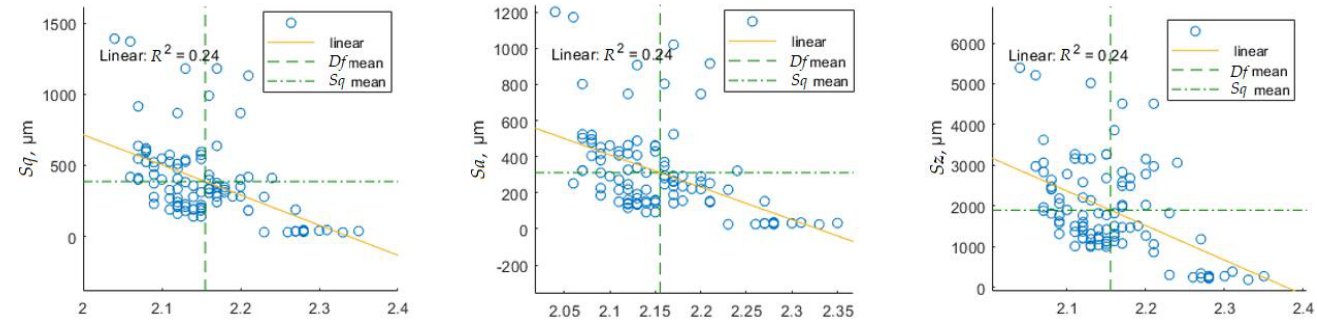
Figure 14. Relationship between areal surface parameters Sx and fractal dimension Df values. Different regression neural network models were compared using Regression